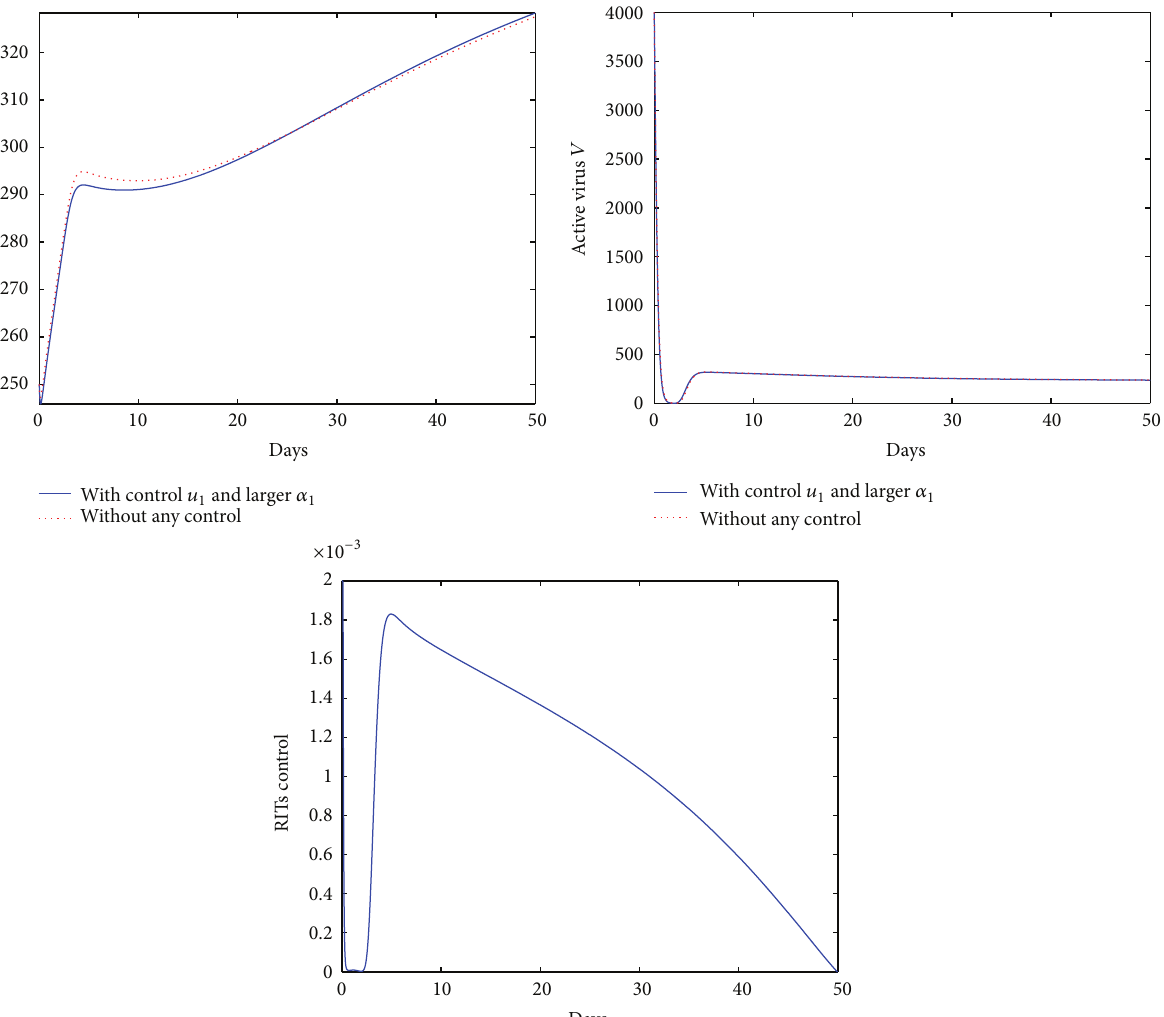
Figure 3: Optimal solutions only using RTIs with sufficiently large weight coefficient 𝛼 1 for a 50-day